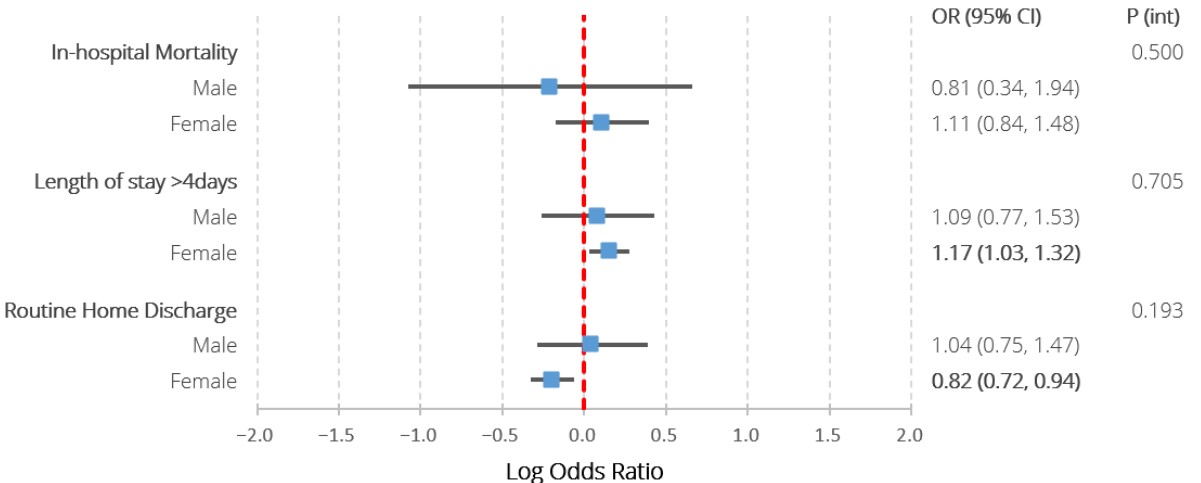
Figure 3. Results of multivariable logistic regression assessing the association between co-morbid SLE and all in-hospital outcomes amongst patients with ischaemic and haemorrhagic stroke, stratified by sex, also including the p values assessing the significance of interaction terms between SLE and sex. Models adjusted for age, ethnicity, hospital region, location and teaching status, stroke type, intravenous thrombolysis/endovascular thrombectomy receipt, previous cerebrovascular accident and a wide range of comorbidities (congestive heart failure, valvular disease, pulmonary circulatory disease, peripheral vascular disease, paralysis, other neurological disorders, metastatic cancer, chronic pulmonary disease, diabetes with chronic complications, diabetes without chronic complications, solid tumour without metastases, hypothyroidism, renal failure, arthropathies excluding SLE, liver disease, peptic ulcer disease, acquired immune deficiency syndrome, coagulopathy, obesity, weight loss, fluid and electrolyte disorders, deficiency anaemia, chronic blood loss anaemia, alcohol abuse, drug abuse, psychosis, depression, hypertension, previous history of cancer, lymphoma, dyslipidaemia, smoking, chronic obstructive pulmonary disease, sepsis, dementia, rheumatic heart disease, Parkinson disease, coronary heart disease, all-cause bleeding, infective endocarditis, pericarditis, pulmonary embolism, transient ischaemic attack, pulmonary hypertension, deep venous thrombosis, atrial fibrillation, pneumonia, aspiration pneumonia, shock). P (int) — p value for interaction term between sex and systemic lupus erythematosus. Statistically significant differences ( p < 0.05) highlighted in bold.